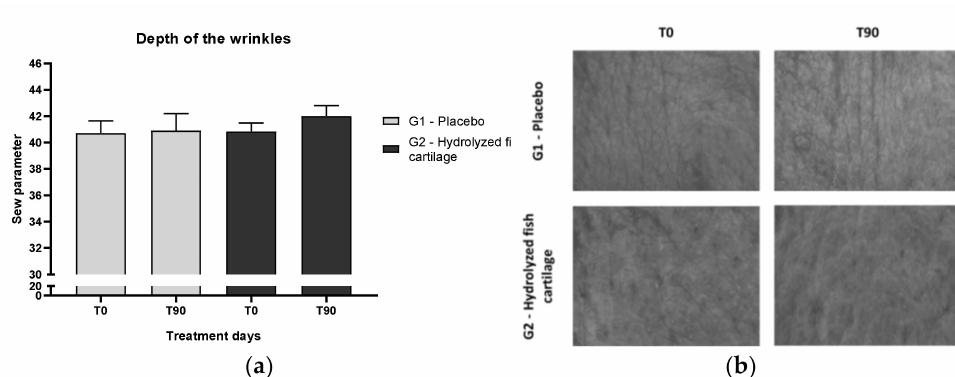
Figure 1. ( a ) Skin microrelief—Sew parameter (number and width of wrinkles) on the nasolabial region of the face, before (T0) and after 90 days (T90) of supplementation with hydrolyzed fish cartilage or placebo. ( b ) Representative skin microrelief images before (T0) and after 90 days (T90) of supplementation with hydrolyzed fish cartilage or placebo. Triplicates of images of each participant were analyzed using the Visioscan ® software.